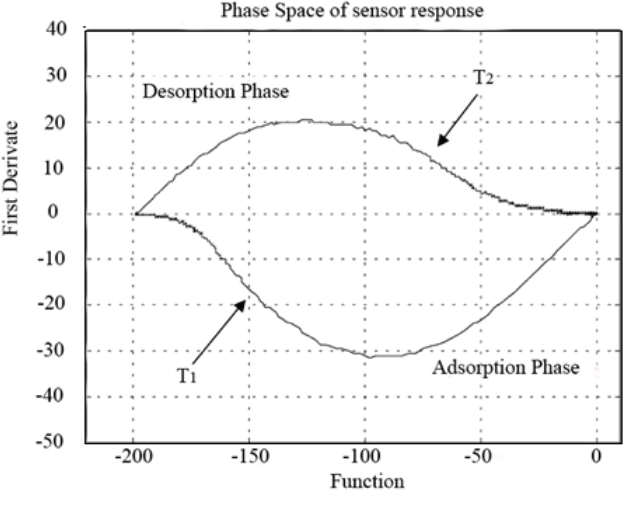
Figure 1. Phase space of sensor with ( ) f t and '( ) f t as